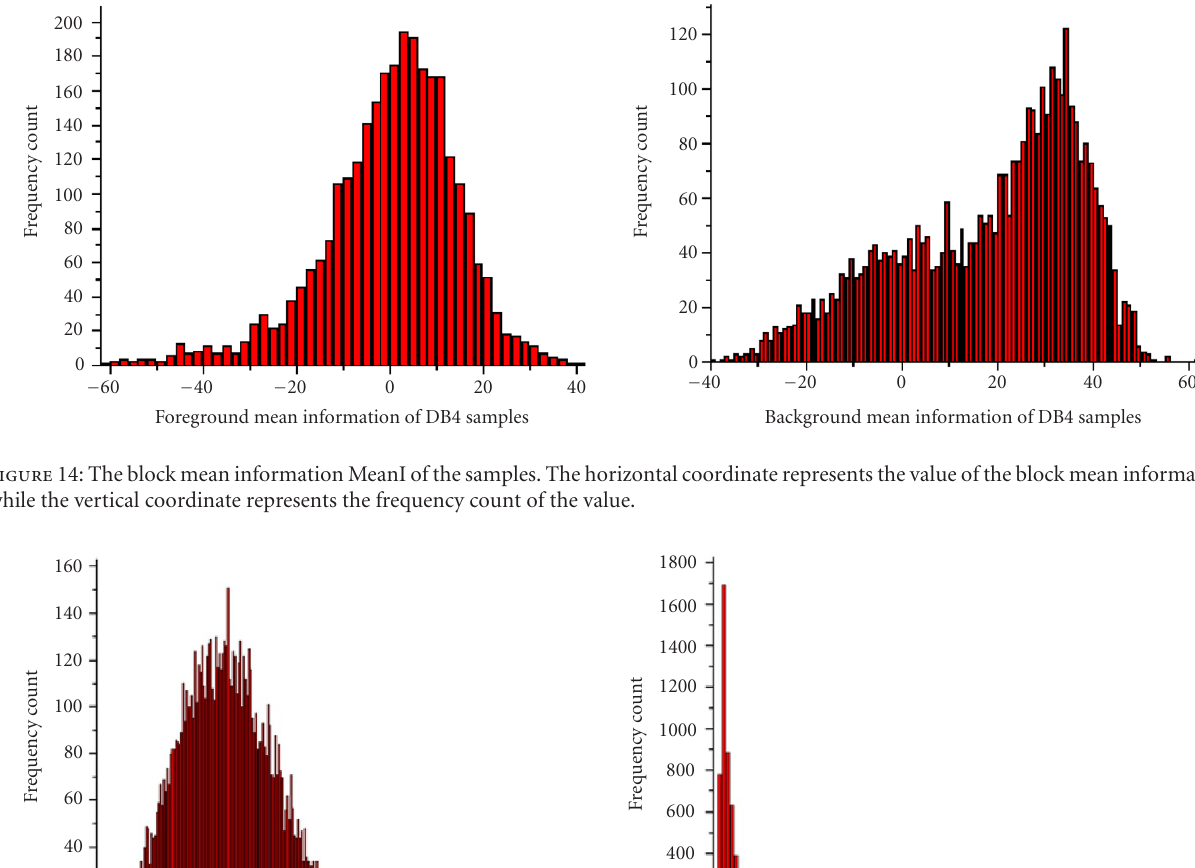
Figure 13: The block mean information MeanI of the samples. The horizontal coordinate represents the value of the block mean information while the vertical coordinate represents the frequency count of the value.